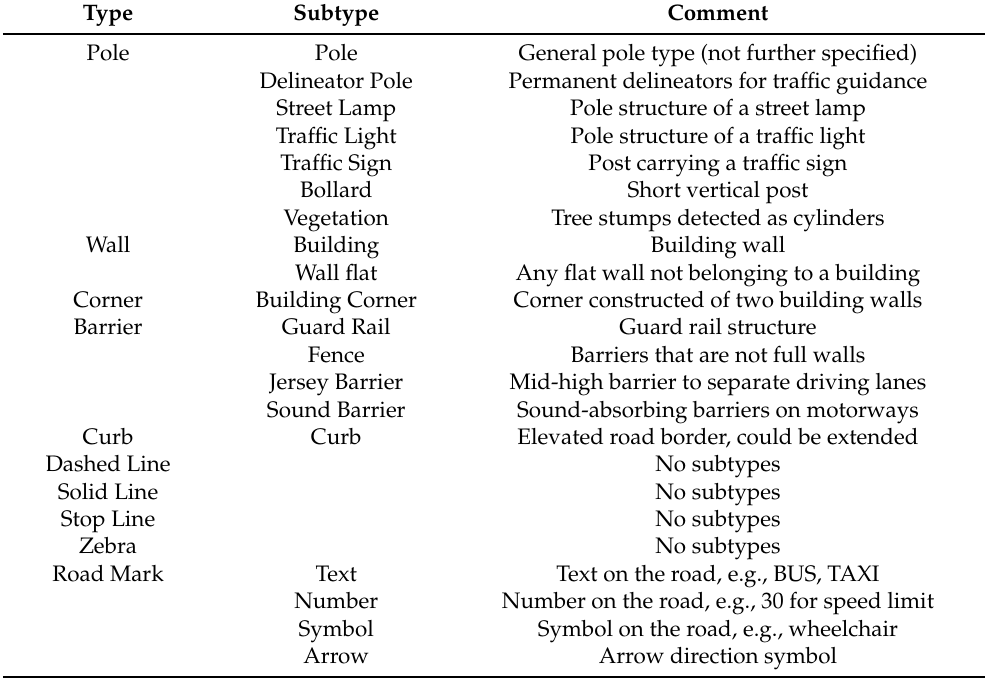
Table 1. Definition of a layered model for landmark classification. The type is based on geometry, whereas subtypes are added for further semantic distinction of the landmark